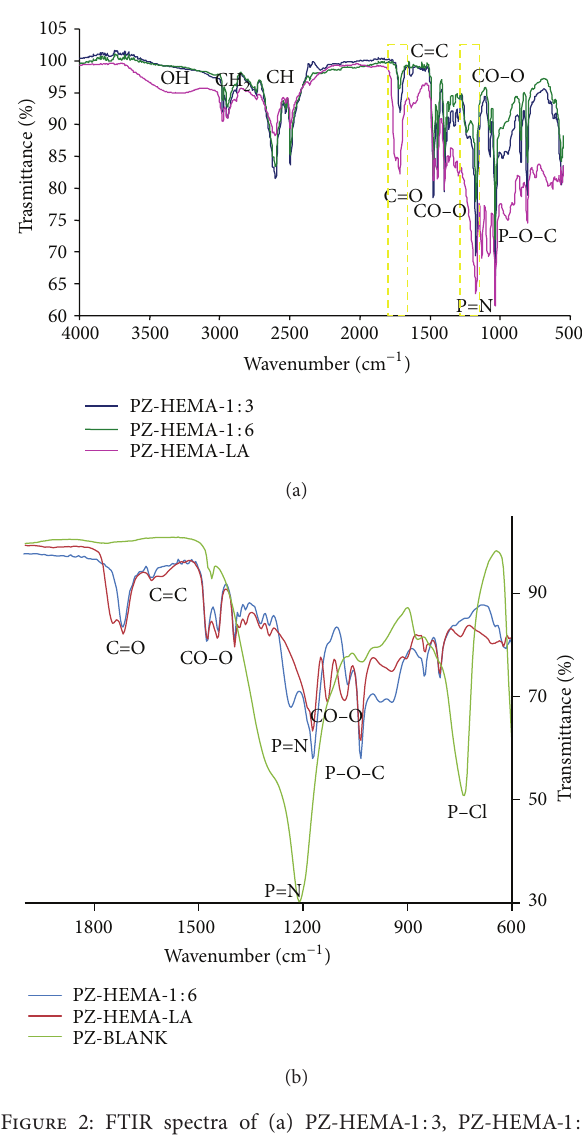
Figure 2: FTIR spectra of (a) PZ-HEMA-1:3, PZ-HEMA-1:6, and PZ-HEMA-LA and (b) PZ-BLANK, PZ-HEMA-1:6, and PZ-